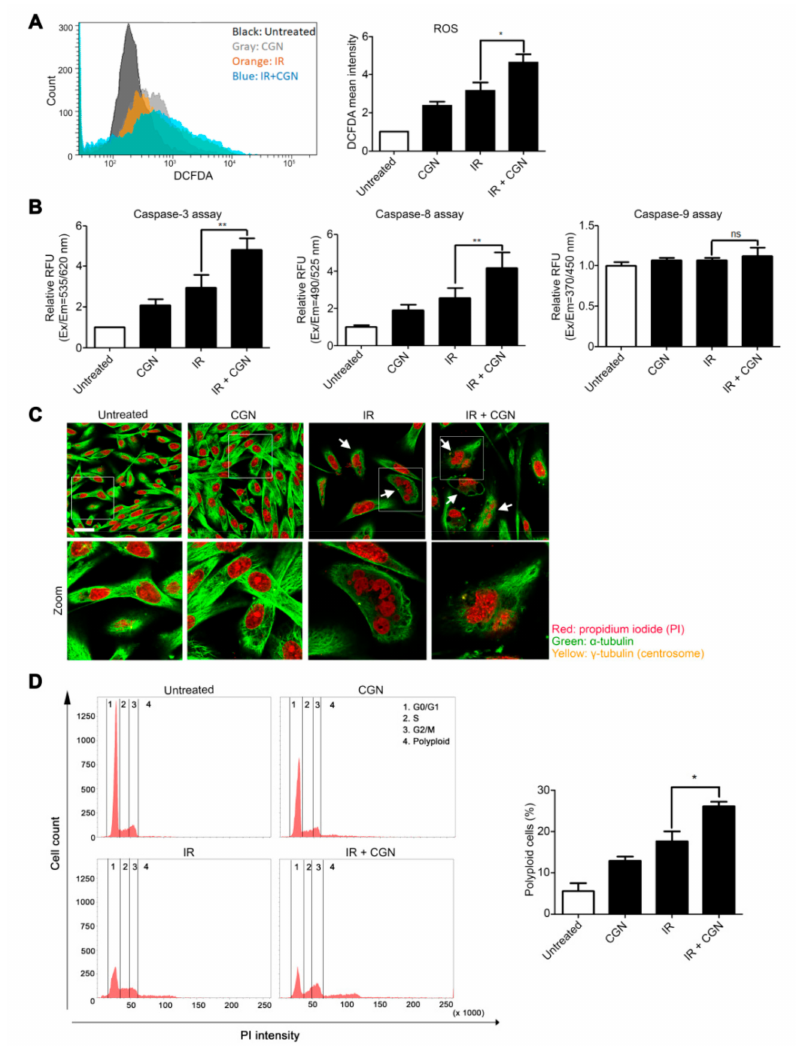
Figure 2. IR exposure in combination with CGN increases ROS accumulation in MDA-MB-231 cells. Cells were treated with 4 Gy IR, followed by CGN on the next day, and then analyzed 72 h after IR. ( A ) ROS was measured by DCFDA. Columns, mean ( n = 5); bars, SE. *, p < 0.05. ( B ) Caspase-3, caspase-8, and caspase-9 activities were detected by microplate reader at specific wavelengths: caspase-3 excitation (Ex) / emission (Em) = 535 / 620 nm; caspase-8 Ex / Em = 490 / 525 nm; caspase-9 Ex / Em = 370 / 450 nm. Columns, mean ( n = 5); bars, SE. **, p < 0.01; ns, not significant. ( C ) Cells stained with α -tubulin (green) and PI (red) after treatments. Bar, 25 µ m. ( D ) To measure polyploid populations, cells were treated with staining solution and PI and analyzed by flow cytometry. Columns, mean ( n = 3); bars, SE. *, p <